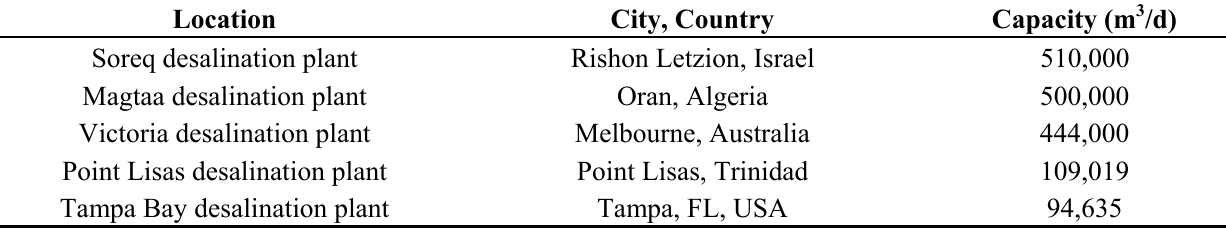
Table 2. Major reverse osmosis (RO) desalination plants in the world. Adapted from [13,16].